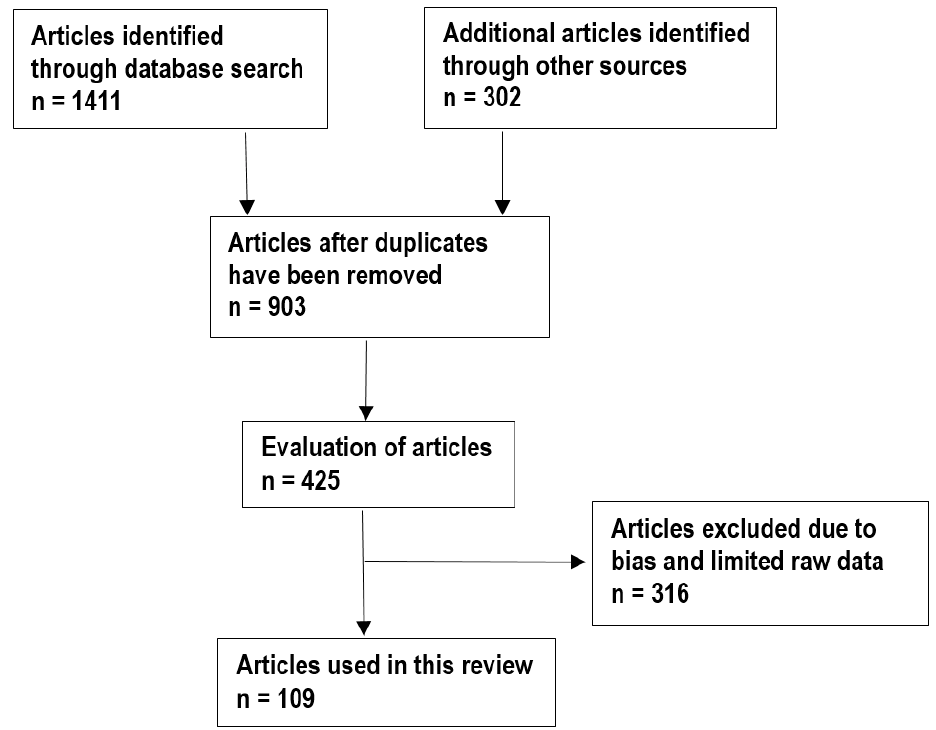
Figure 2. Flow diagram showing the literature search and selection processes.